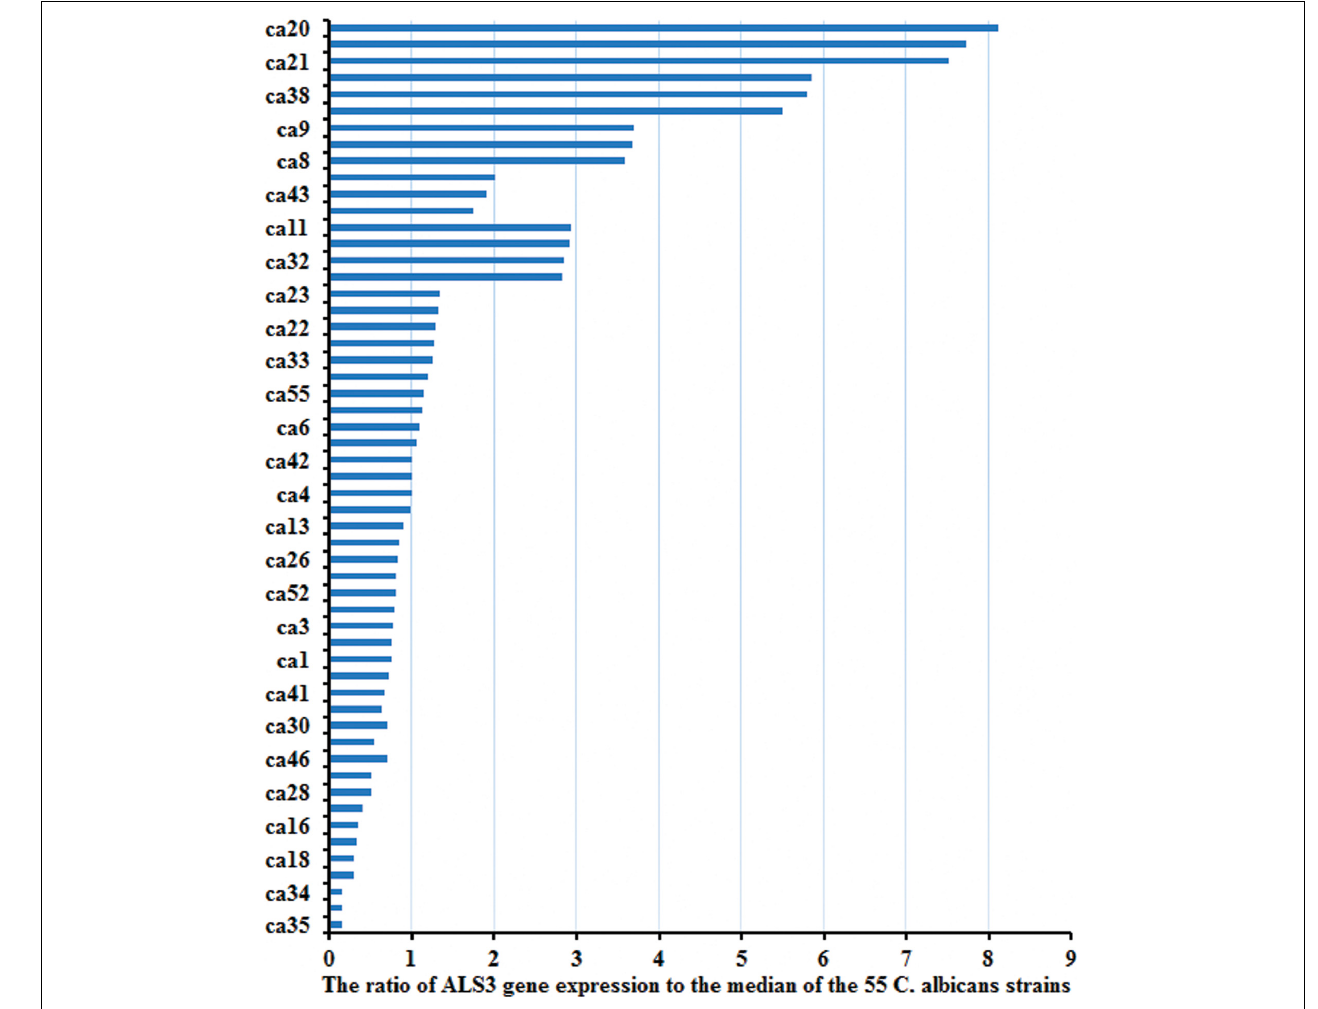
FIGURE 2 | The expression of ALS3 gene was obvious differences in the 55 strains. There were obvious differences of the ALS3 gene expression level in the 55 C. albicans when they were collected from patients.